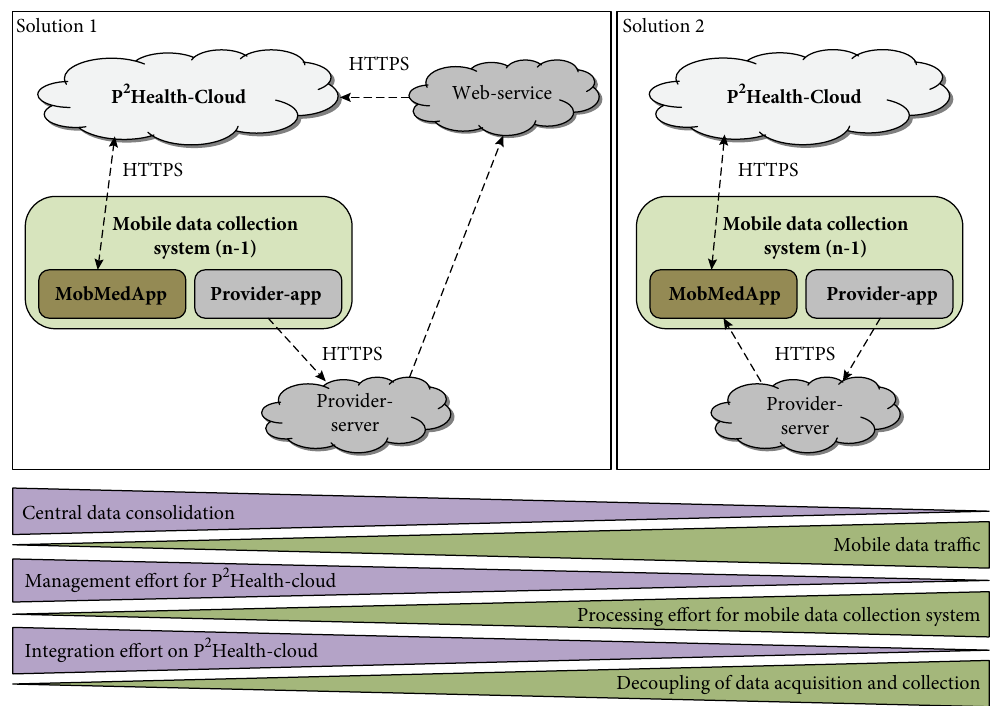
Figure 3: Comparison of two solutions for the integration of provider-cloud servers for a process-specific data